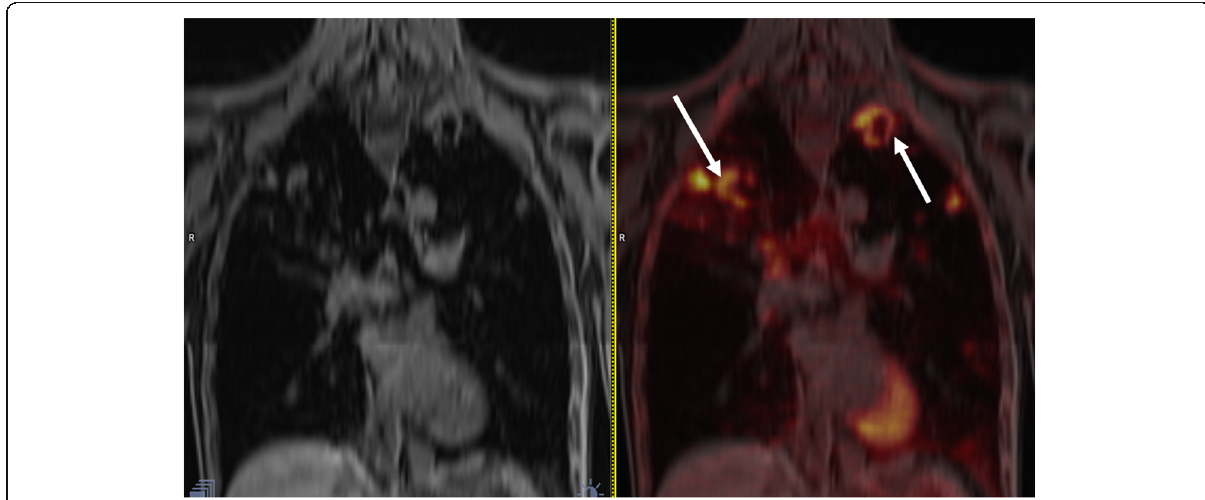
Fig. 2 Hybrid PET/MRI imaging of the chest. Images of chest revealed multiple patches of abnormal FDG uptake in bilateral upper lobes, right middle lobe, and apical segment of left lower lobe (white